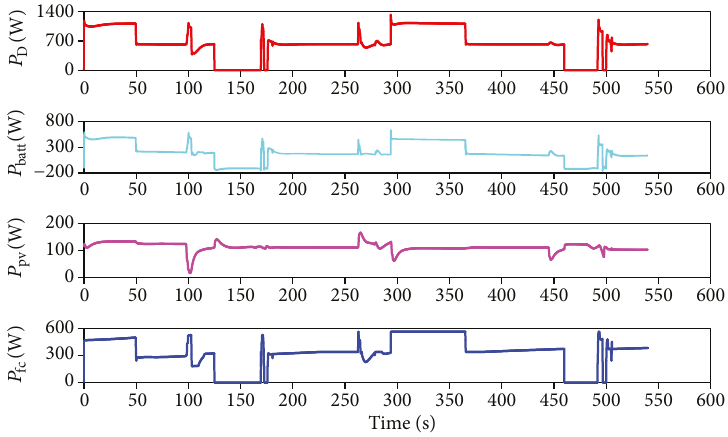
Figure 11: Demand power and power distribution.